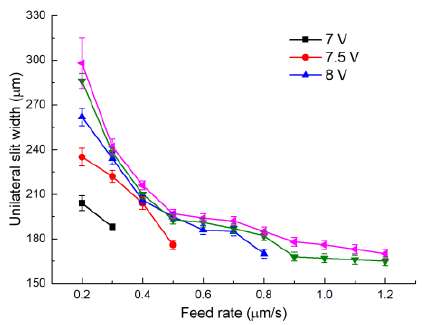
Figure 11. The variation of unilateral slit width with electrode feed rate, utilizing an electrode measuring 0.3 mm in diameter.